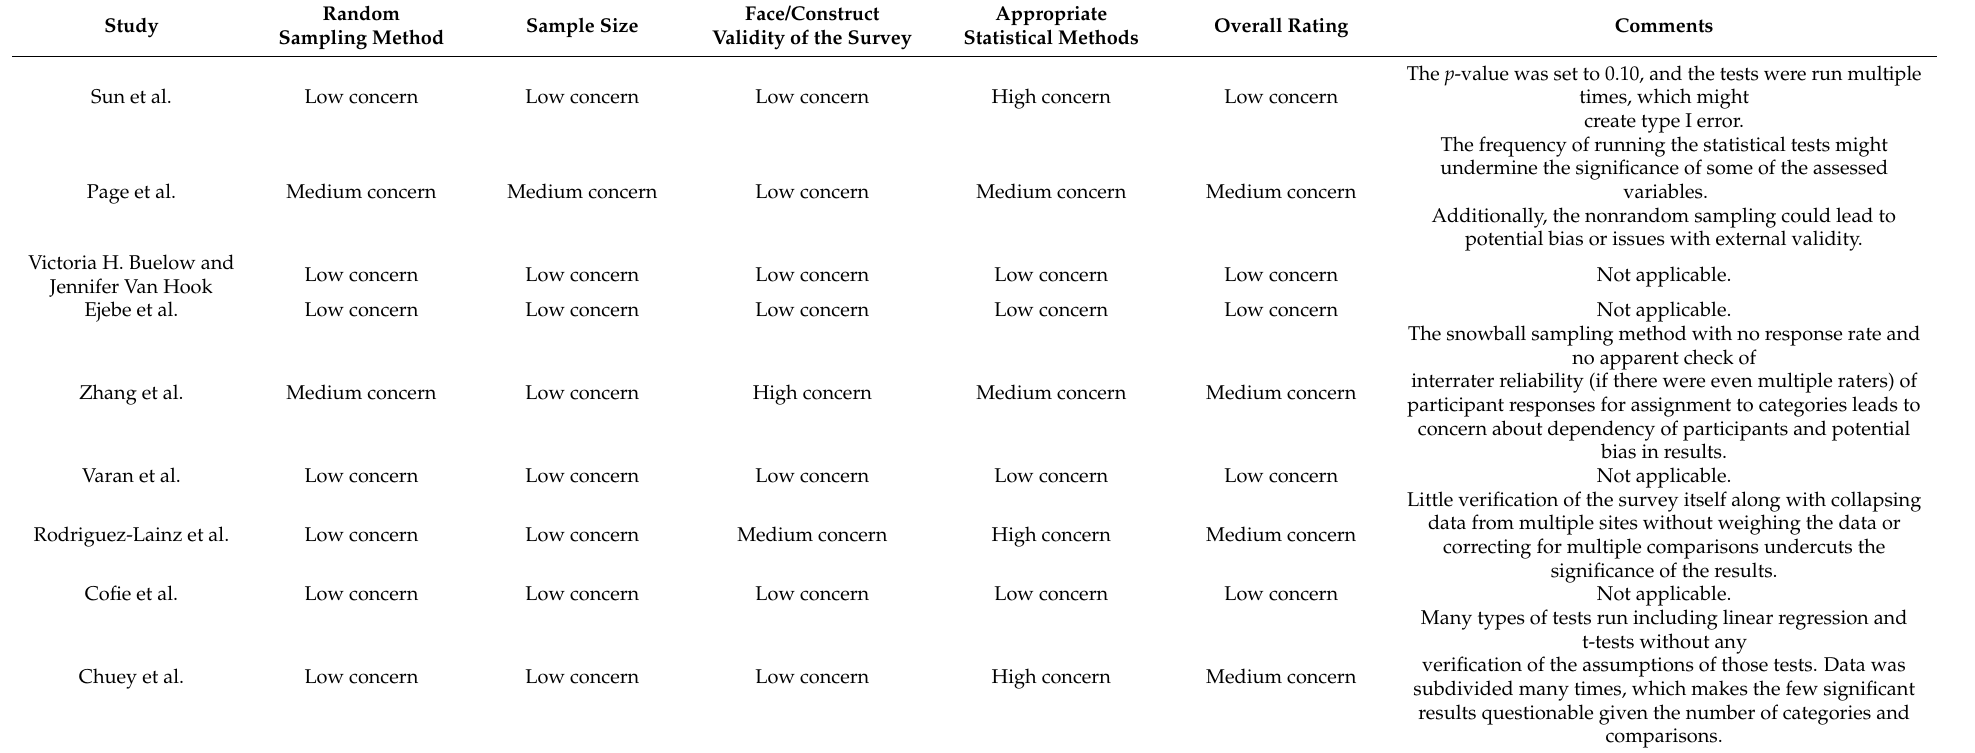
Table A2. Quality assessment of the included studies in the